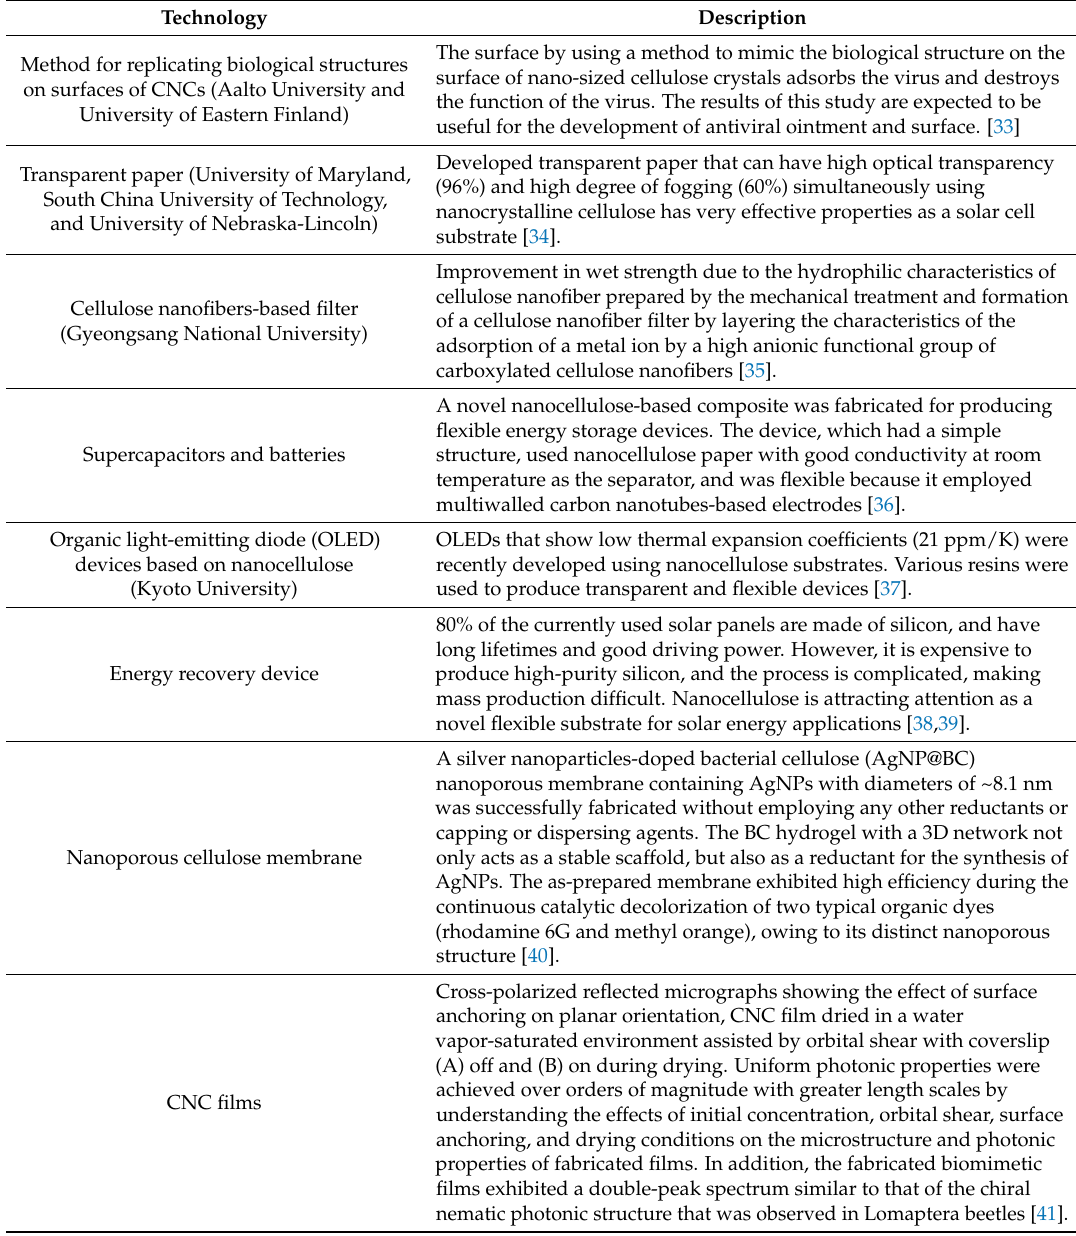
Table 2. Use of nanocellulose in the